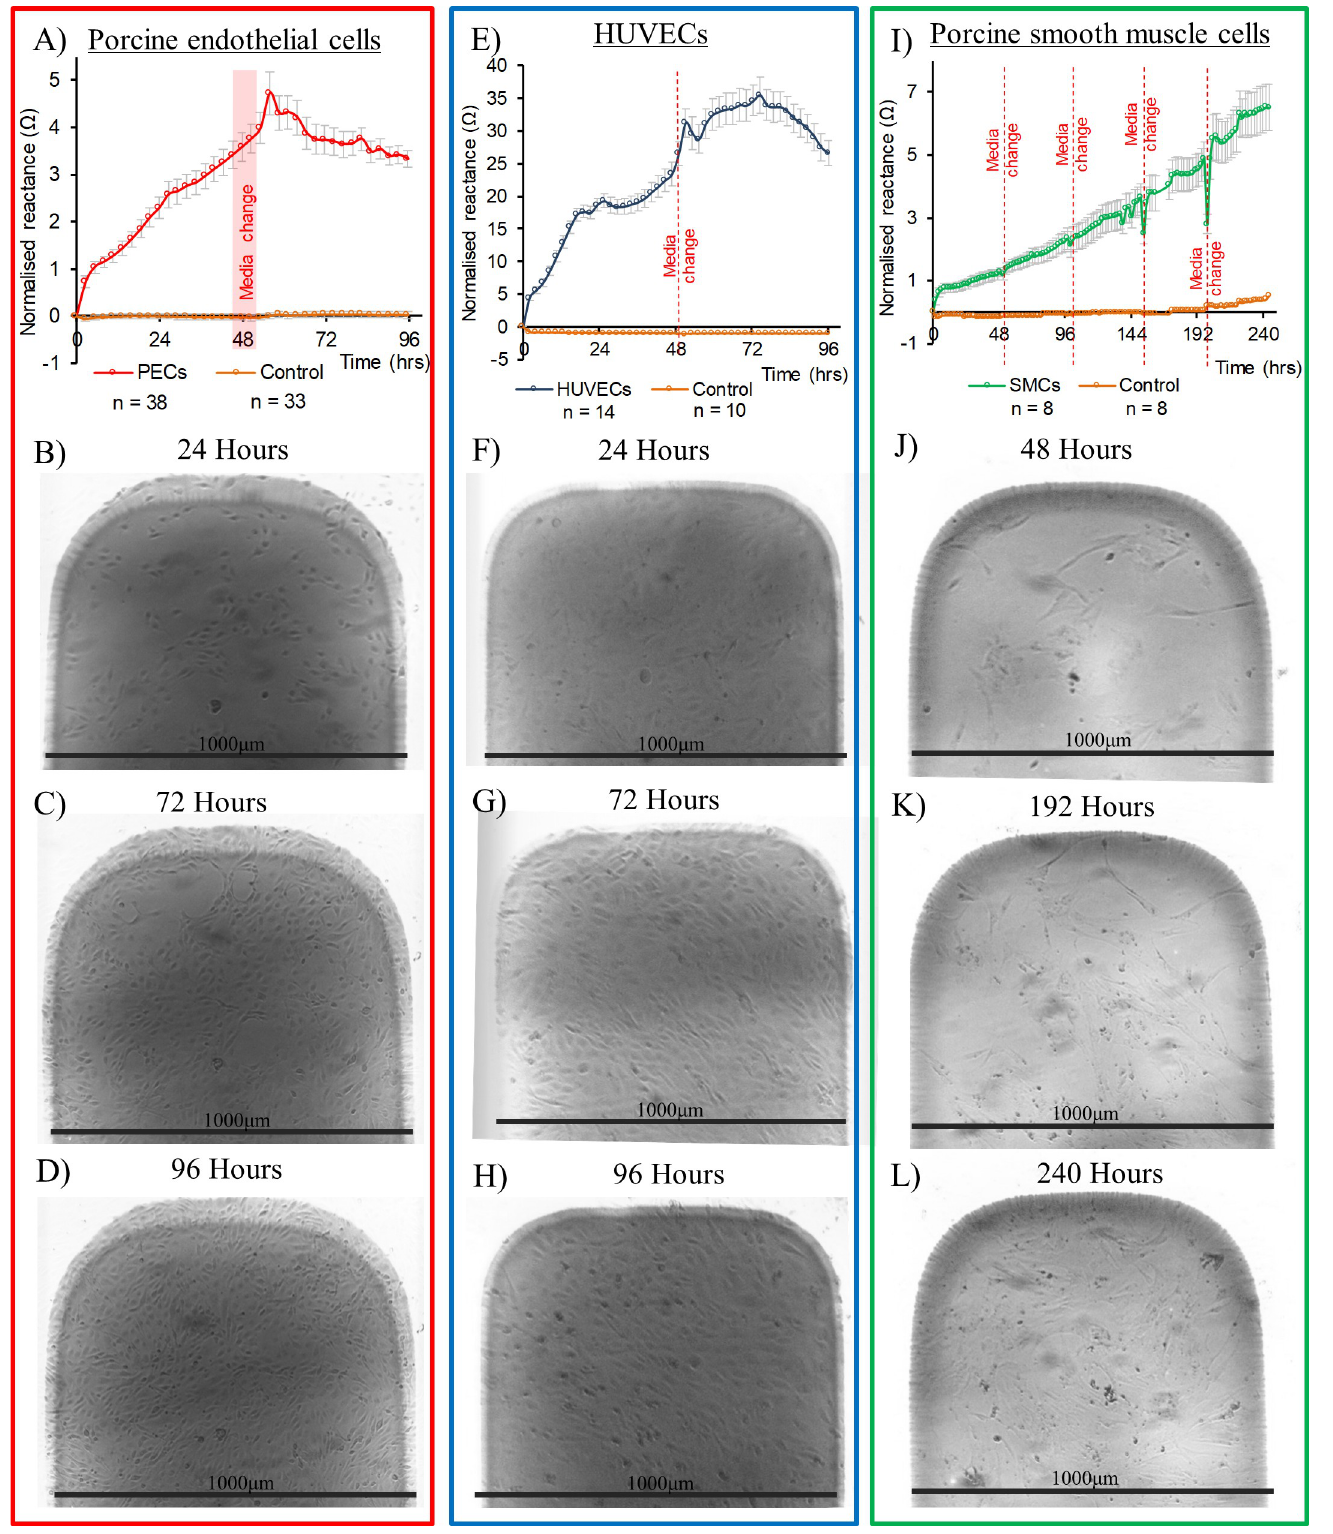
Fig 5. Reactance profiles at 10kHz and corresponding representative light microscopy images. Light microscopy images for Porcine ECs (B) to (D), HUVECs (F) to (H) and SMCs (J) to (L). Black scale bars are provided by known electrode width of 1000 μ m. Mean reactance profiles at 10kHz for cell seeded and cell free electrodes (A) Porcine ECs, (E) HUVECs and (I) SMCs. Red lines represent media changes. Error bars are ± SEM. https://doi.org/10.1371/journal.pone.0206758.g005 PLOS ONE | https://doi.org/10.1371/journal.pone.0206758 November5,